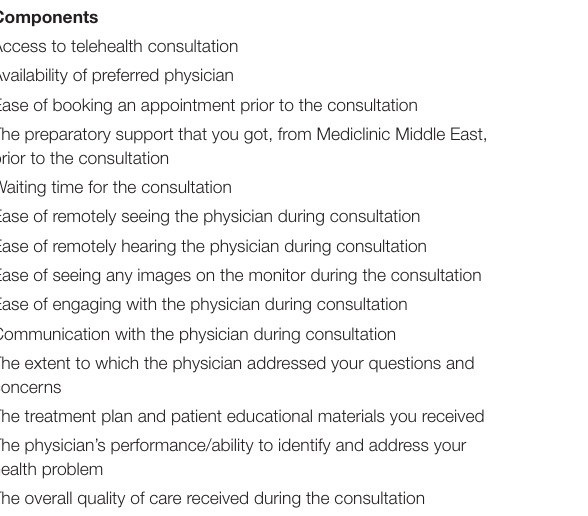
TABLE 1 | Outline of the third (main) segment of the